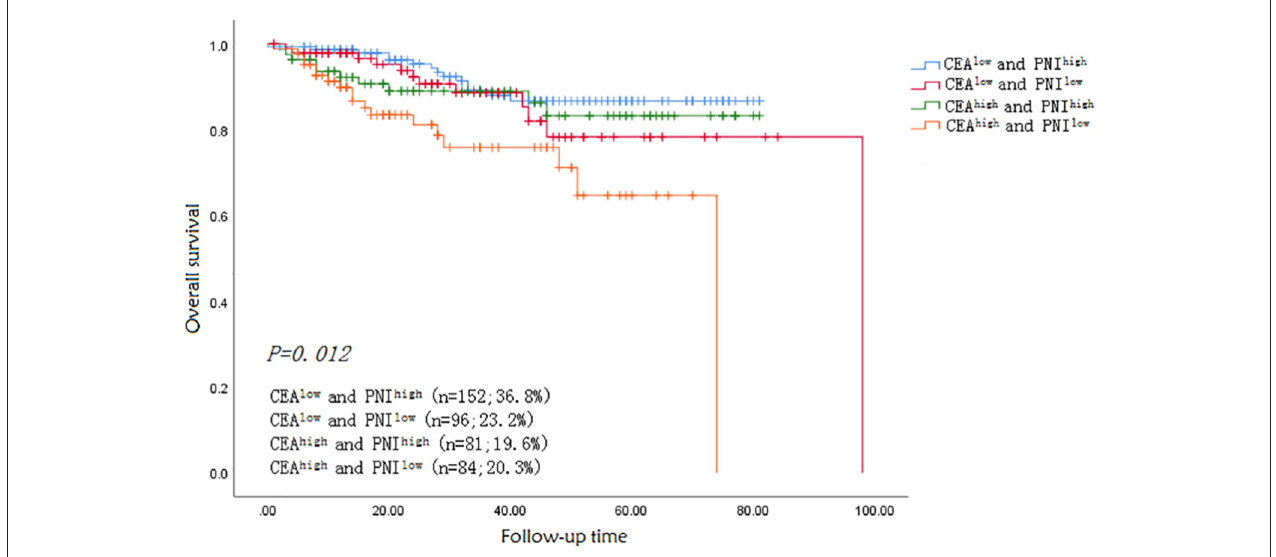
FIGURE 4 | Kaplan–Meier (K–M) overall survival curve for CEA/PNI.